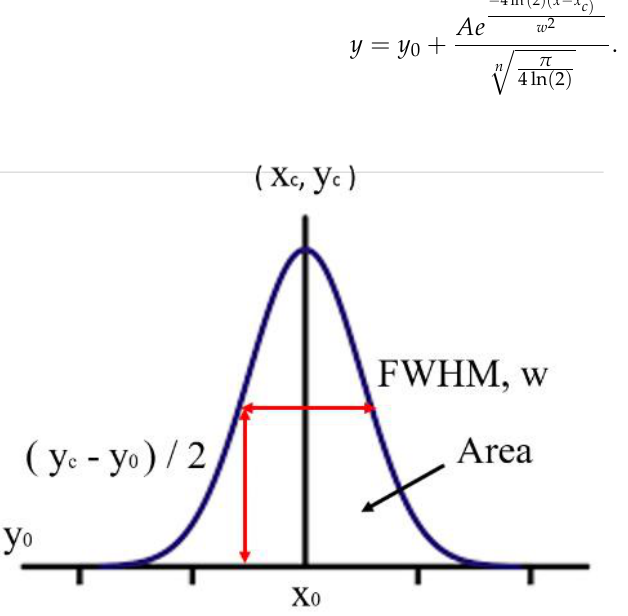
Figure 4. The Gaussian function is used for multiple peak fitting in Raman spectra.